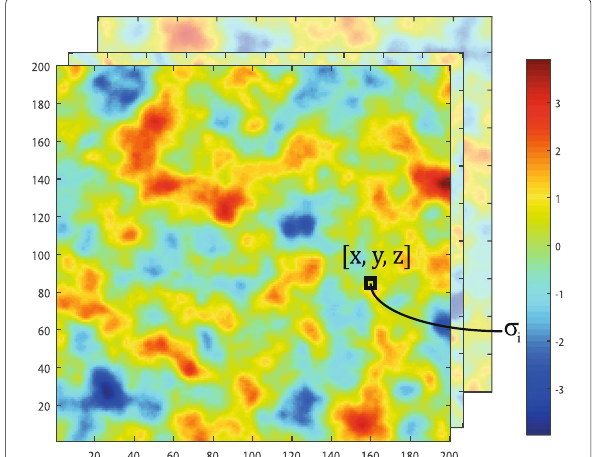
Fig. 5 Spatially correlated LSP maps. For each of the LSPs, a spatially correlated log normally distributed map is generated, as indicated in the figure